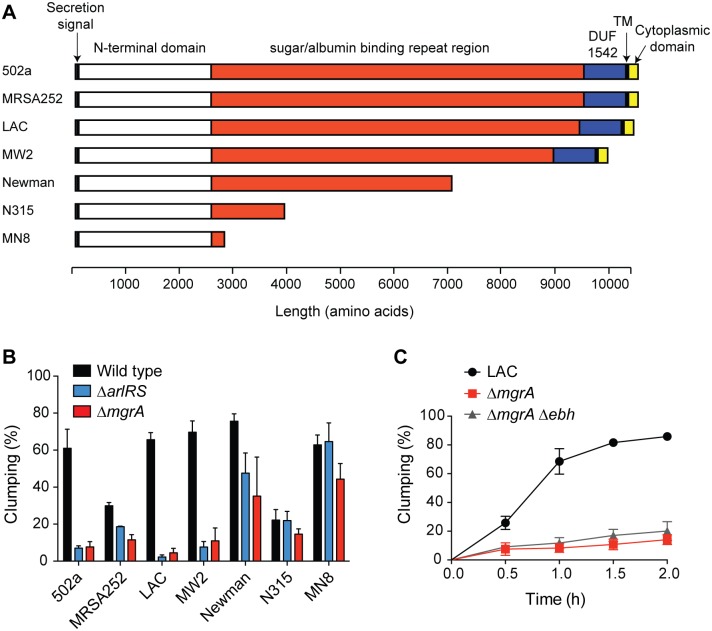
Comparison of clumping phenotypes in strains with truncated ebh genes.(A) Schematic of predicted Ebh proteins from a collection of S. aureus strains, showing only the product of the first predicted ebh ORF for each strain. Key domains, as well as the secretion signal sequence and transmembrane (TM) domain are indicated. (B) Clumping of arlRS and mgrA mutants in each of the strains shown in (A) after 1 h of incubation with human plasma. (C) Clumping time course of LAC, mgrA mutant and mgrA ebh double mutants incubated with human plasma. All clumping results represent averages of three separate experiments.